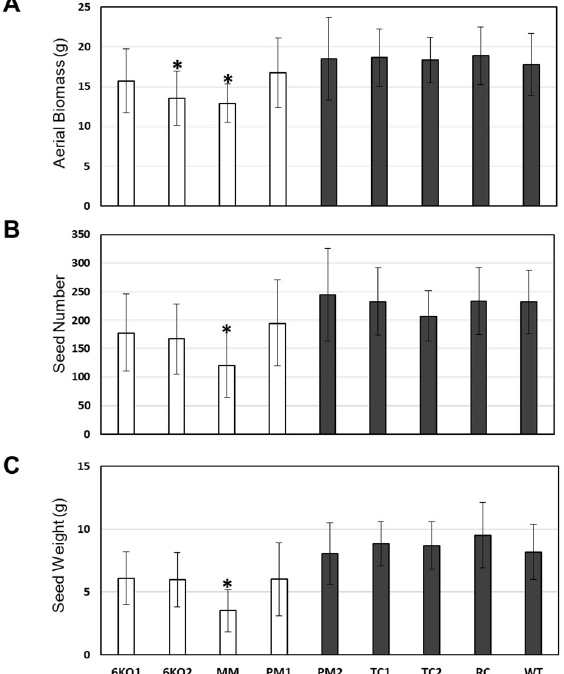
Figure 4. Growth of well-watered wheat lines. ( A ) Average weight of dry aboveground biomass (g), ( B ) seed number and ( C ) total seed weight (g) per plant. Results averaged from 3 independent experiments. * indicates statistically significant differences from controls ( p < 0.05; n = 14). White bars indicate plants with mutant stem phenotype; dark grey bars indicate plants with wildtype stems.